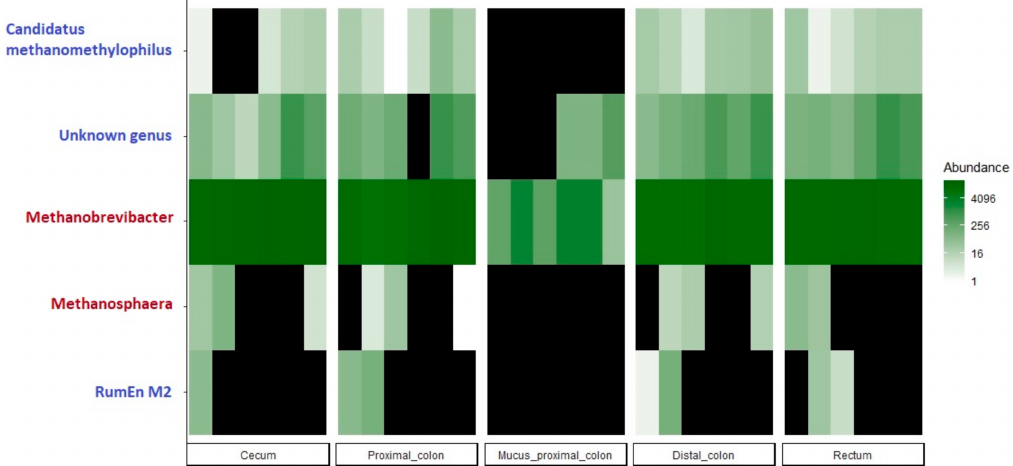
Figure 5. Top 20 of the most abundant archaeal OTUs along the GIT of weaning piglets (blue names correspond to Methanomethylophilaceae family and red names correspond to Methanobacteriaceae family, black color corresponds to an abundance of